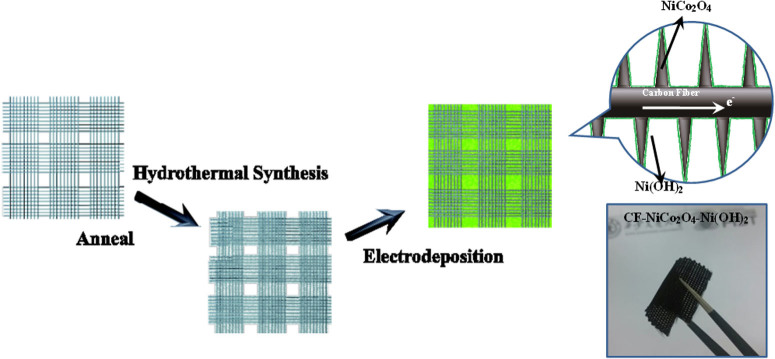
Schematic diagram of the preparation procedure of the CF–NiCo2O4–Ni (OH)2 3D hybrid structured electrode material.